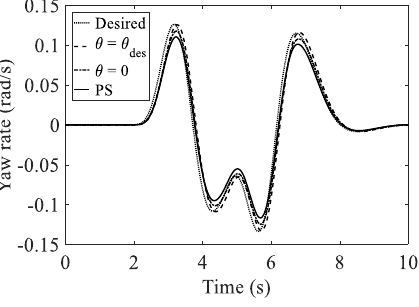
Figure 18. Yaw rate.